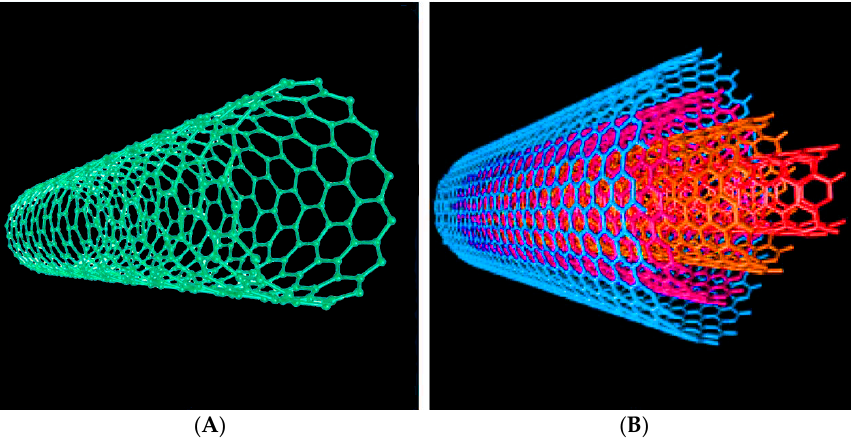
Figure 1. Schematics of an individual ( A ) SWCNT and ( B ) MWCNT. Cited from Reference [9] with permission.